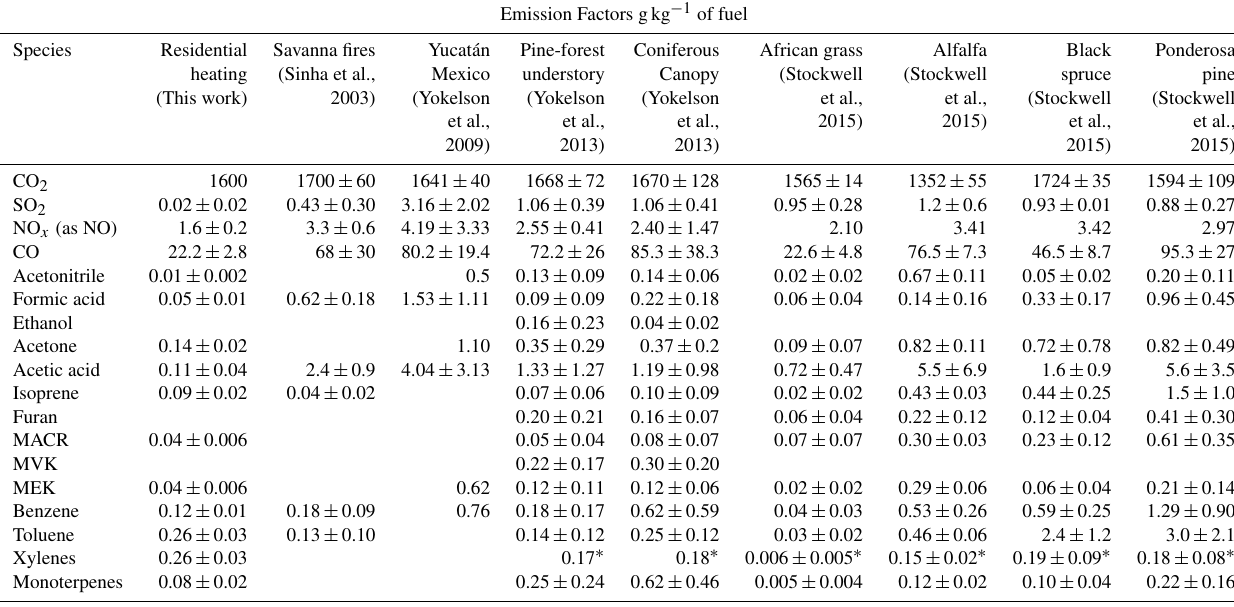
Table 4. Emission factors (gkg − 1 ) for VOCs and other species during biomass